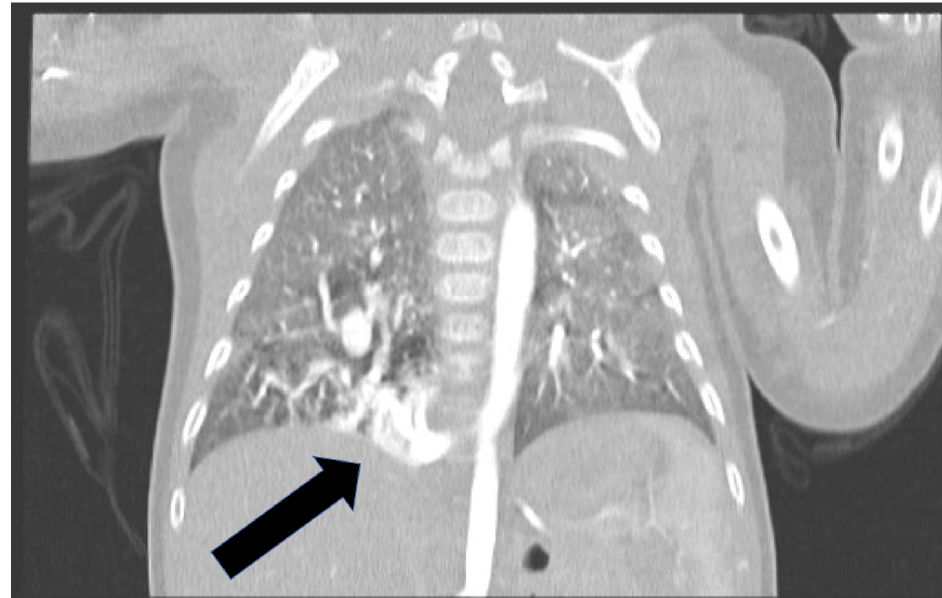
Figure 1. In patient 1, a very large branch of 6.5 mm in diameter (equal to abdominal aorta), originating from the right side of thoracic descending aorta and giving systemic arterial supply to the malformation was showed.